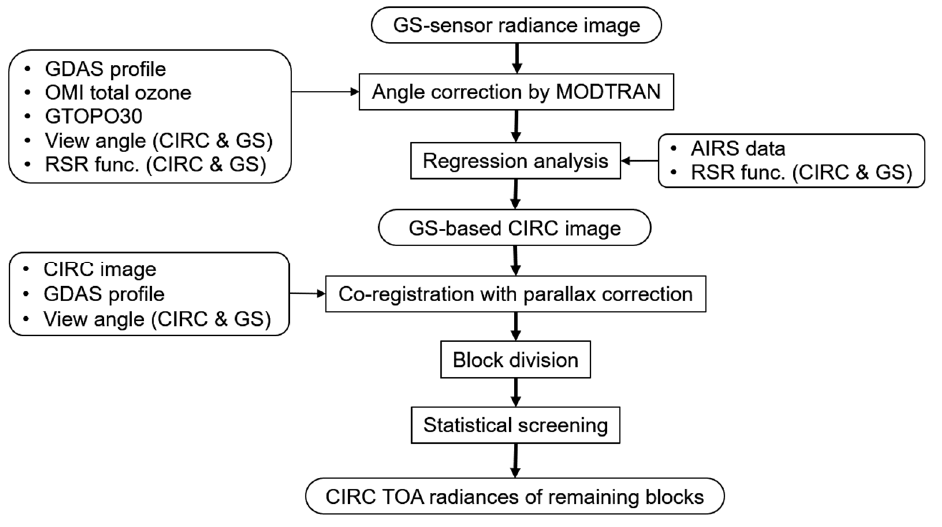
Figure 9. Processing flow of the TOA radiance estimation in cross-calibration (CC).